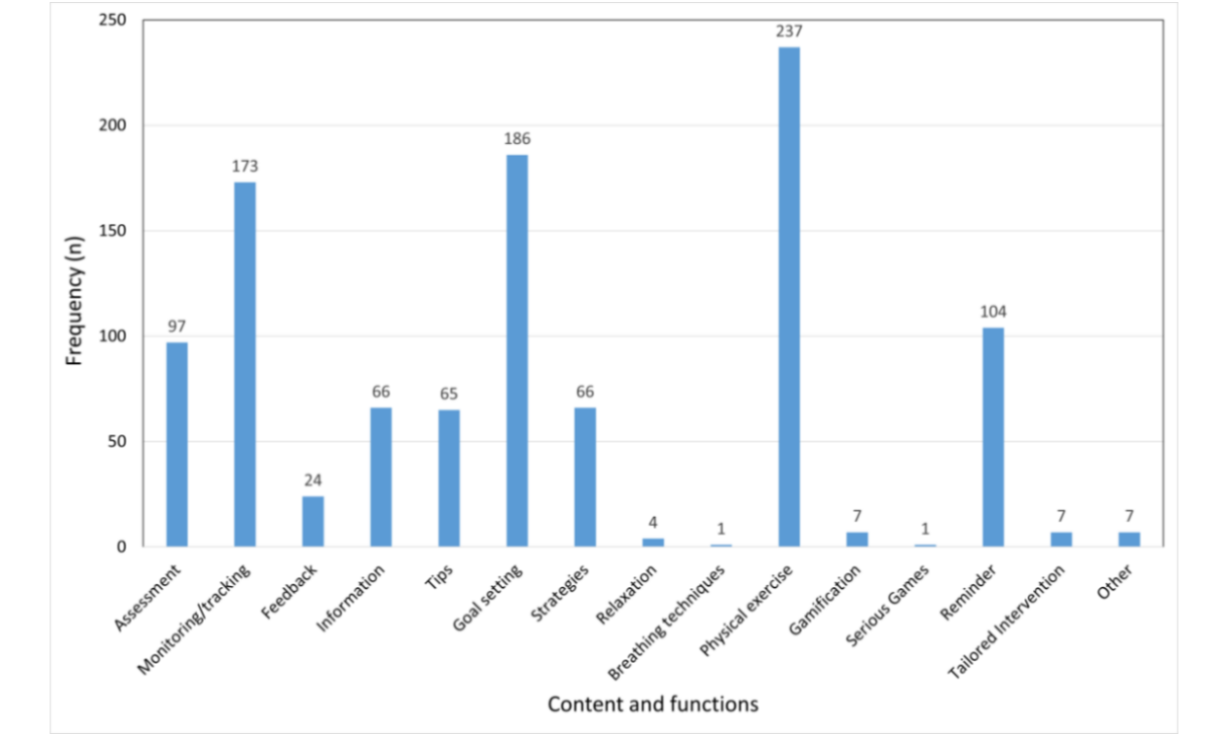
Figure 2. Content and functions of the included